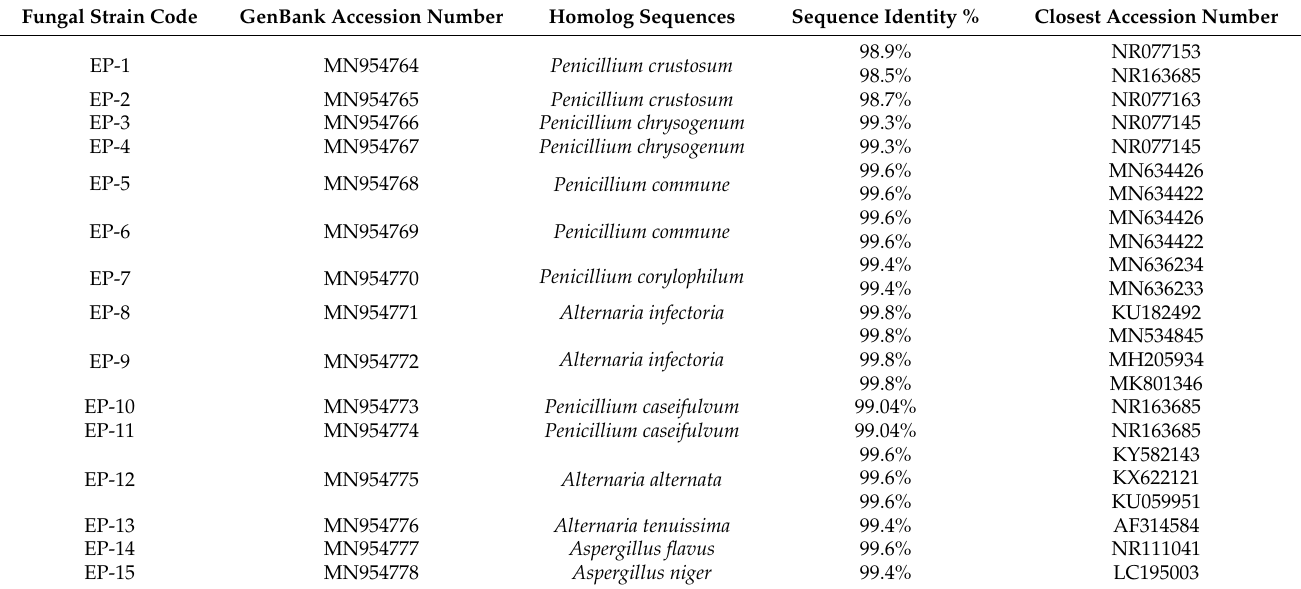
Table 1. The ITS sequence identification of the endophytic fungal strains from E. Pachyclada